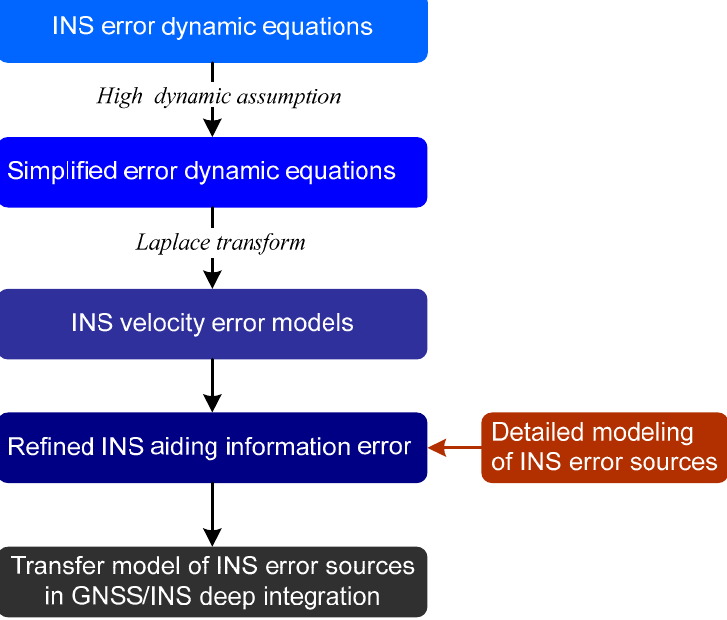
Figure 3. The modeling process of the relationship of INS error sources and the carrier phase tracking error in the GNSS/INS deep integration.